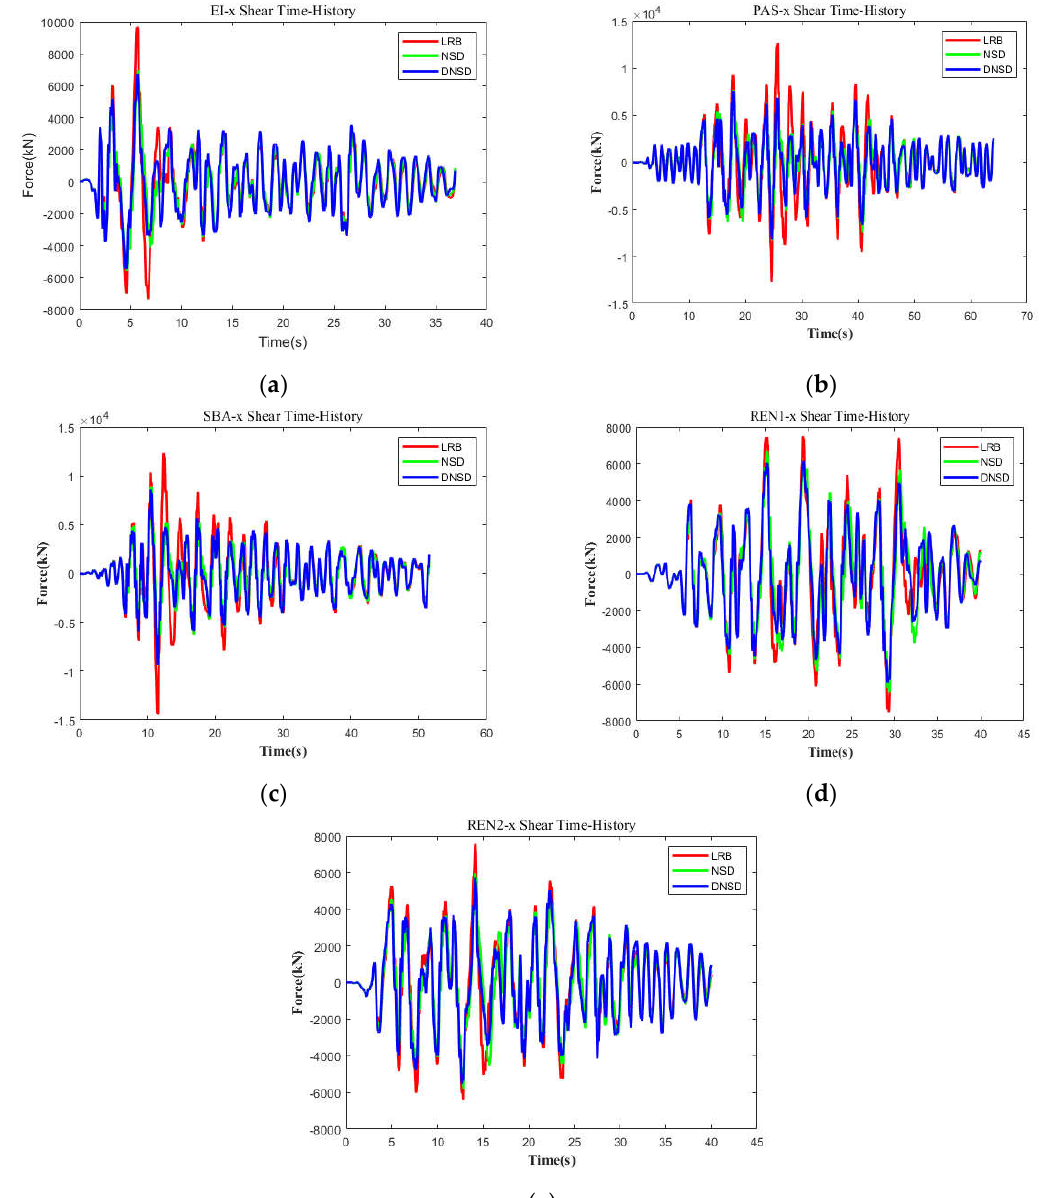
Figure 21. Time-history comparison of bottom shear response among three models under different earthquake waves at a peak of 0.6 g. ( a ) Time history of shear response of ground floor under 0.6 g peak of EL wave. ( b ) Time history of shear response of ground floor under 0.6 g peak of PAS wave. ( c ) Time history of shear response of ground floor under 0.6 g peak of SBA wave. ( d ) Time history of shear response of ground floor under 0.6 g peak of REN1 wave. ( e ) Time history of shear response of ground floor under 0.6 g peak of REN2 wave.